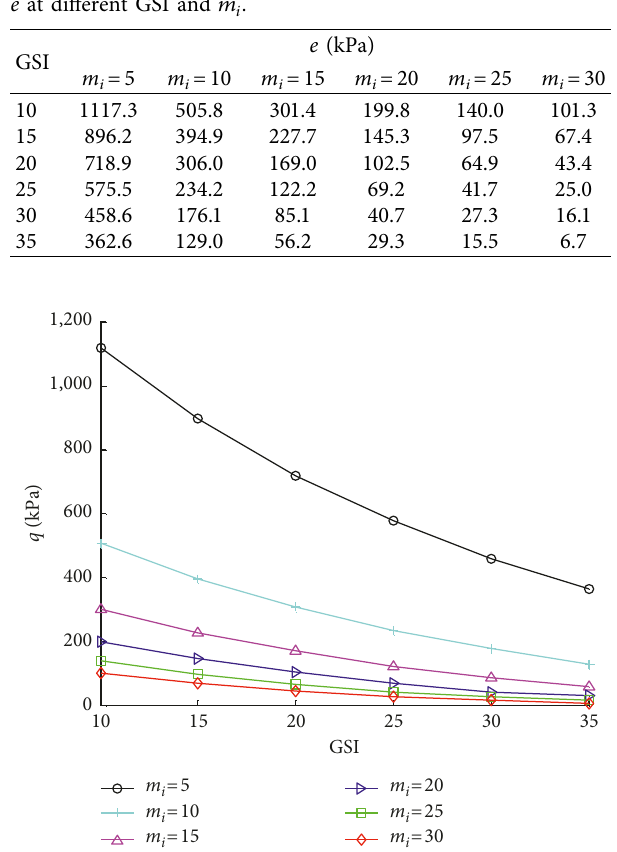
Figure 8: Effect of GSI and m i on the surrounding rock pressure q .